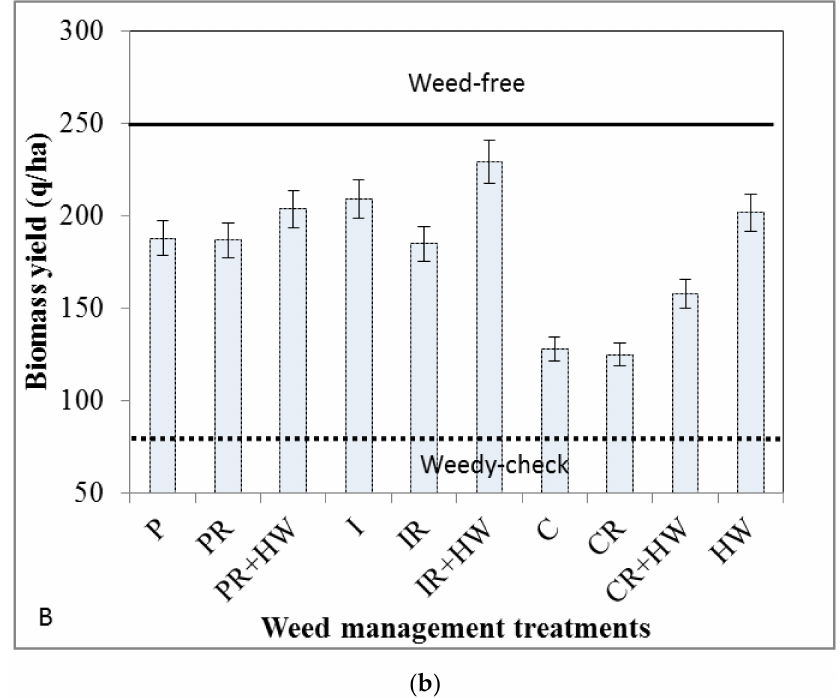
Figure 3. Biomass yield recorded during the year ( a ) 2018 and ( b ) 2019 as affected by weed manage- ment treatments. The vertical bars represent standard error of means at p = 0.05. The solid line (—) represents the biomass of the weed-free treatment, and the dotted line ( − − ) represents the biomass of